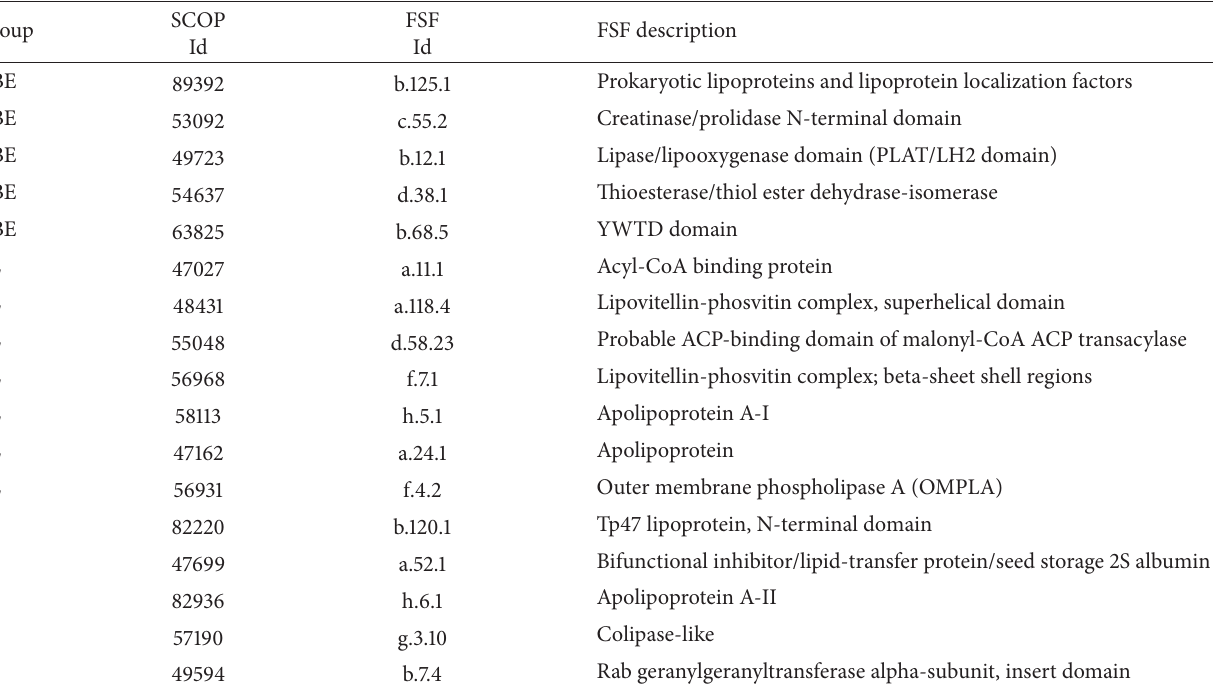
Table 1: List of FSFs involved in lipid metabolism and transport along with taxonomic distribution (data taken from [122, 123]). FSF Group SCOP FSF description Id Id ABE 89392